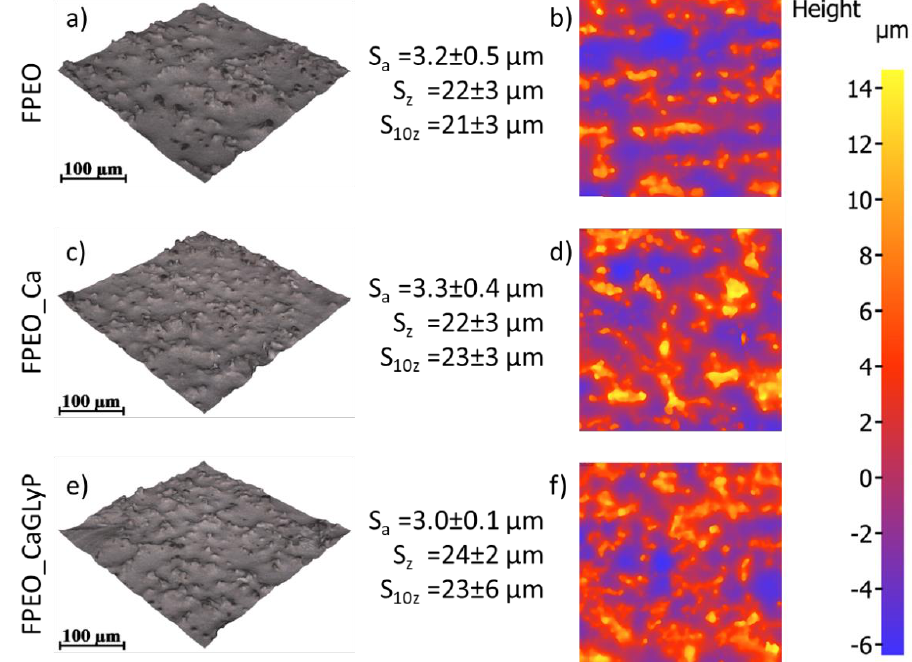
Figure 3. Optical profilometry micrographs and surface roughness parameters of the FPEO coatings, including the 3D-rendered images ( a , c , e ), 2D topographical maps ( b , d , f ) and the corresponding calculated surface parameters. Sa, Sz and S10z are the average height, maximum height and ten-point height of the selected area, respectively.